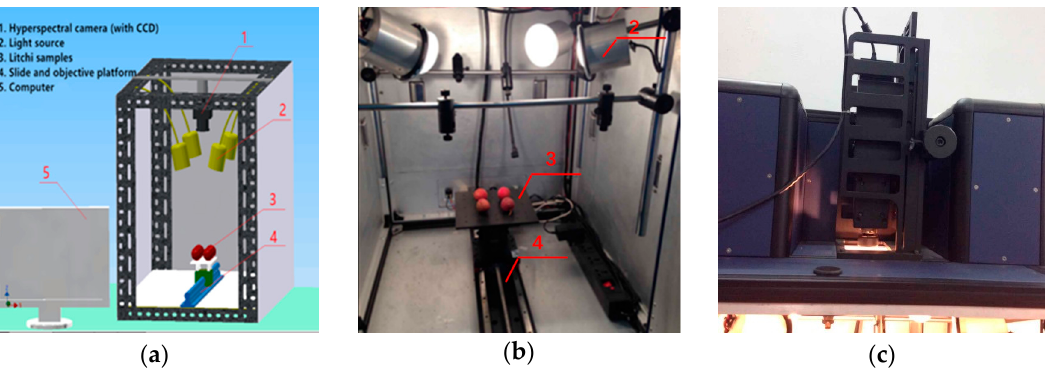
Figure 1. Hyperspectral image acquisition system. ( a ) Sketch map, ( b ) Physical picture, ( c ) Hyperspectral camera with CCD.